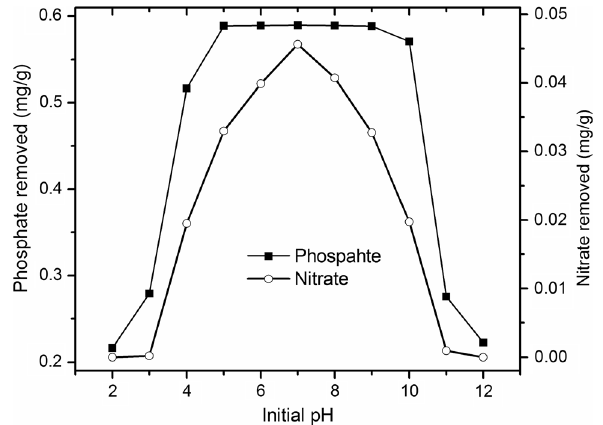
Fig. 1 Effects of contact time on simultaneous removal of nitrate and phosphate ions